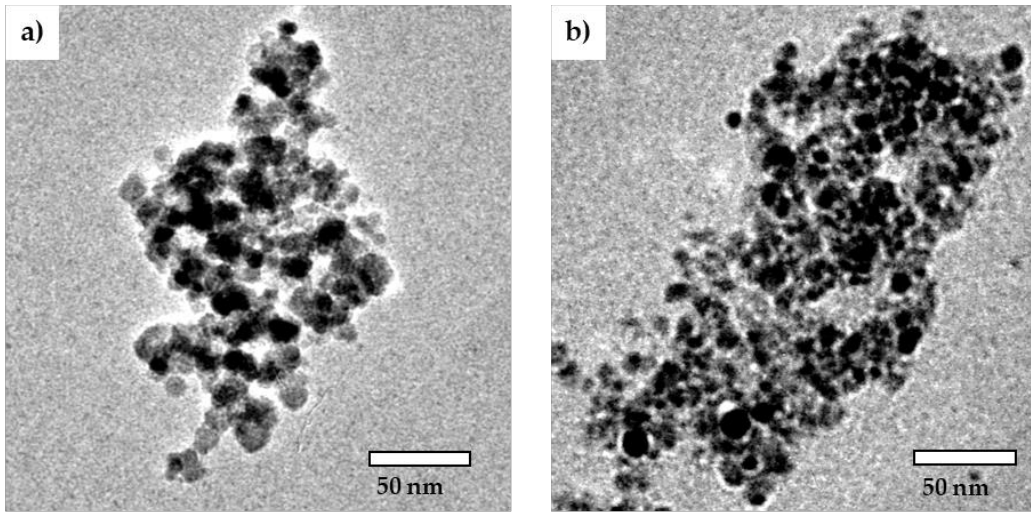
Figure A4. Energy dispersive X-ray spectra of ( a ) Cit-SPIONs and ( b ) Cit-Au-SPIONs. A gold related peak appeared after gold coating process.